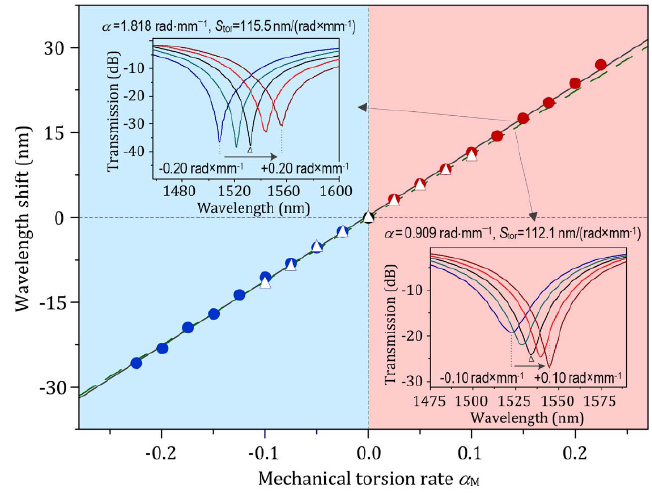
Figure 18. Wavelength shift as a function of the mechanical torsion rate under two cases. Adapted with permission from Ref. [22] © The Optical Society.